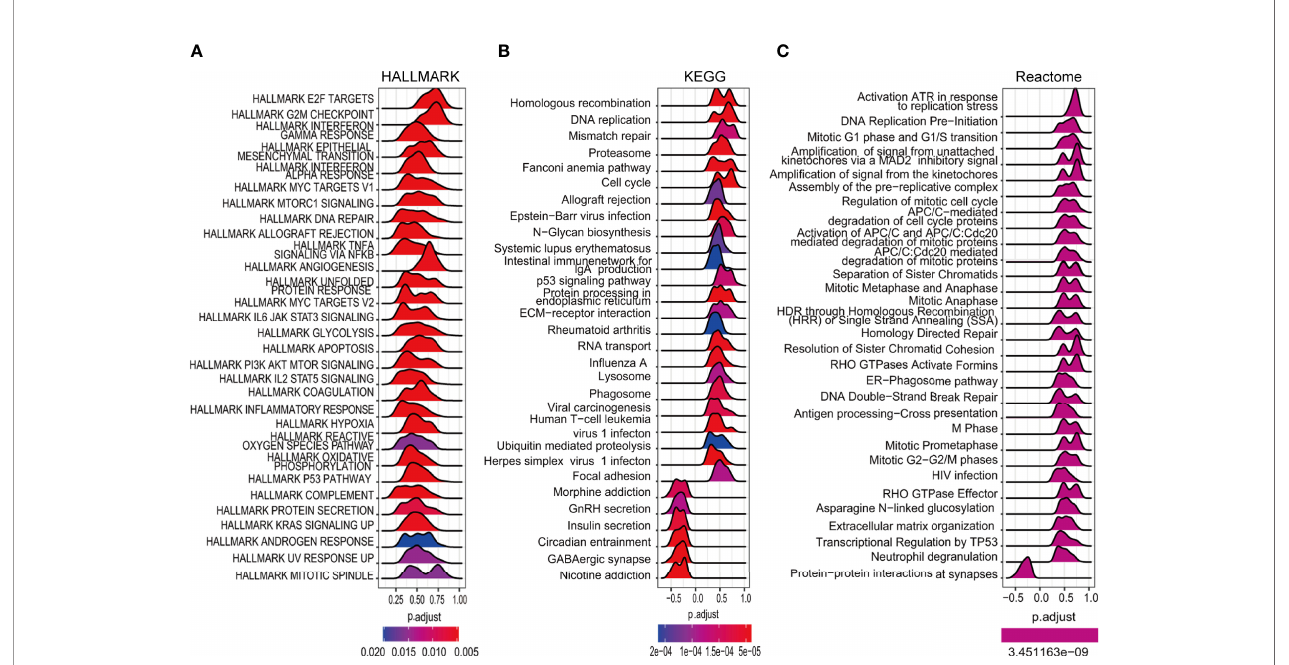
FIGURE 8 | Enrichment analysis of cancer-essential FRG signature genes in the TCGA cohort. The top 30 gene sets of HALLMARK (A) , KEGG (B) , and Reactome (C)